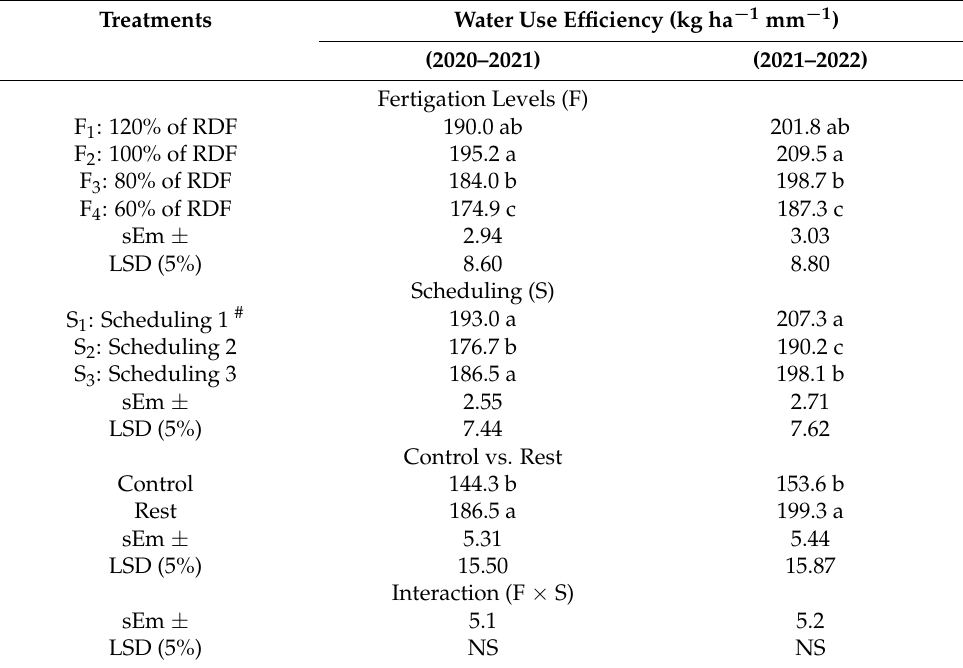
Table 8. Impact of fertigation levels and scheduling on water use efficiency in tomato plants.